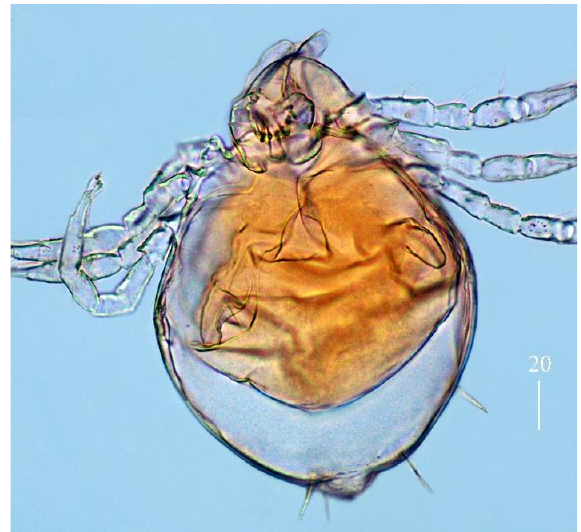
Figure 11. Geckobia mysoriensis sp. n. larva with forming chrysalis, dorsal view.